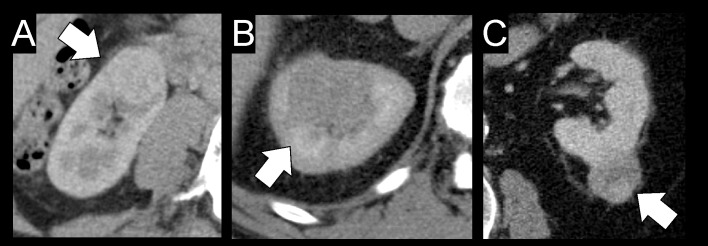
CT image examples of three different patients with renal cell carcinoma and different tumor nuclear grade.Whilst Fig 1A shows a grade 1 tumor of the right kidney of a 49 year-old female patient, Fig 1B is displaying a grade 2 clear-cell RCC of a 58 year-old male patient, and Fig 1C is from a 78 year-old male patient with a grade 3 tumor. All tumors are approximately the same size; however, a grading based on visual criteria only is not possible.